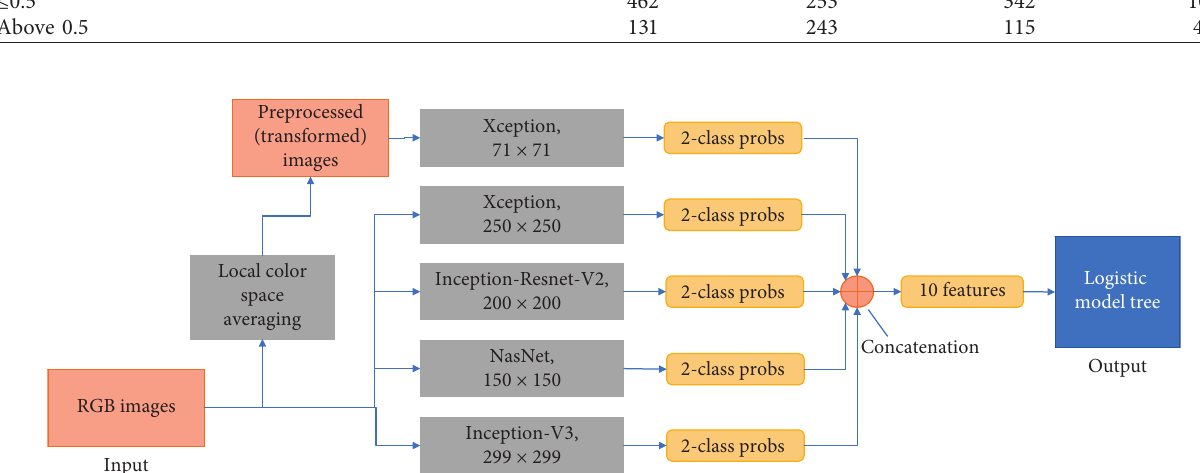
Figure 3: Overall schematic representation of the model building. The two types of input images (RGB and transformed) fed into five neural networks are shown. Each network accepts a rescaled image (shown below the name of the architecture) and produces two probabilities. The ten resulting probabilities are then concatenated to form a feature array of size 10 and fed as input to a logistic model tree which acts as the final classifier in this